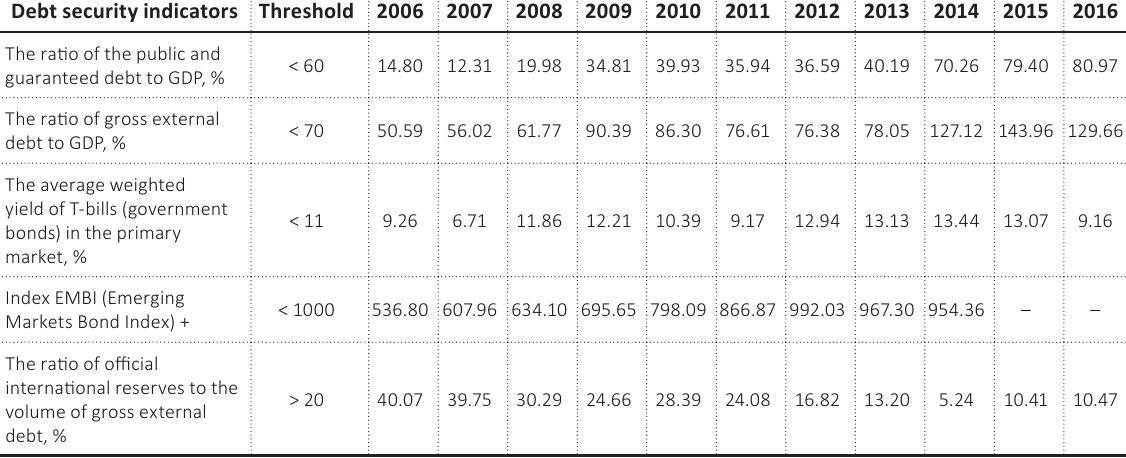
Table A2. Results of calculation of the debt security indicators (methodology from 2013)